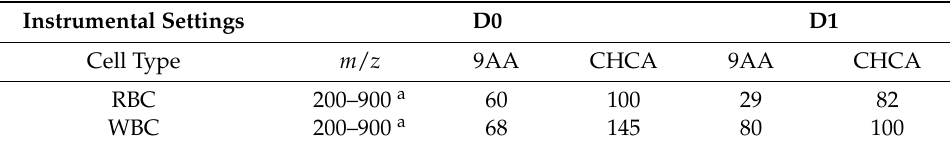
Table 1. Differentially expressed m / z signal counts. Instrumental